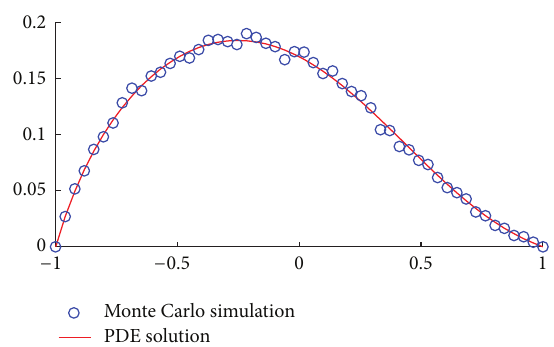
Figure 4: The Monte Carlo simulation and the PDE solution of a 1D 1-step